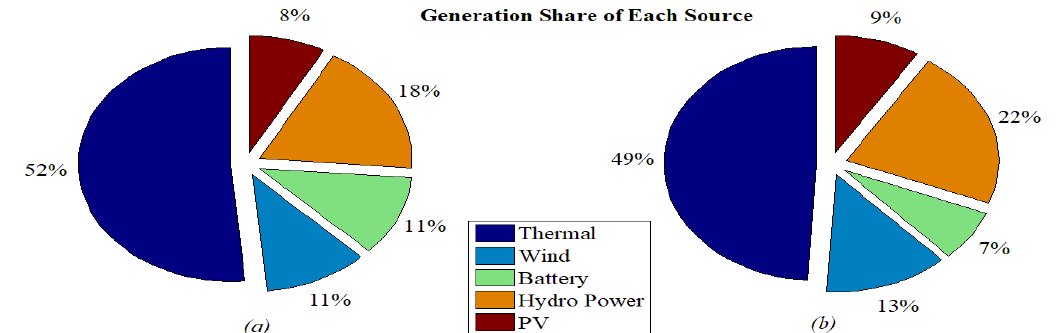
Fig. 16: Share of each generation (a) in [48] and (b) by developed technique